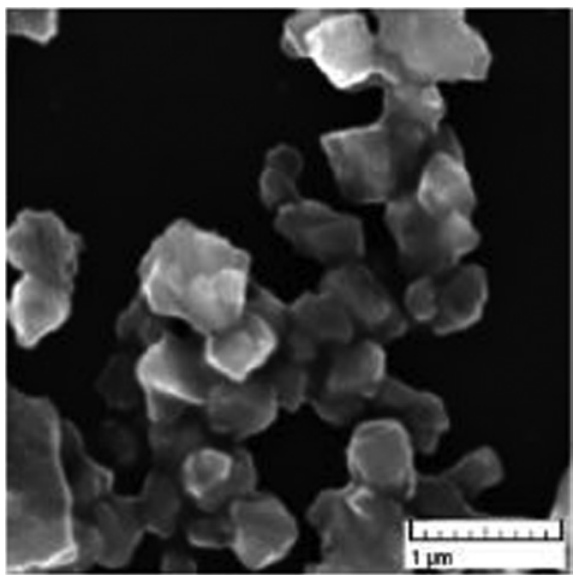
Figure 9: Sem Microstructures of Titanium Carbide Synthesized at 1300 ° C for 1 h.